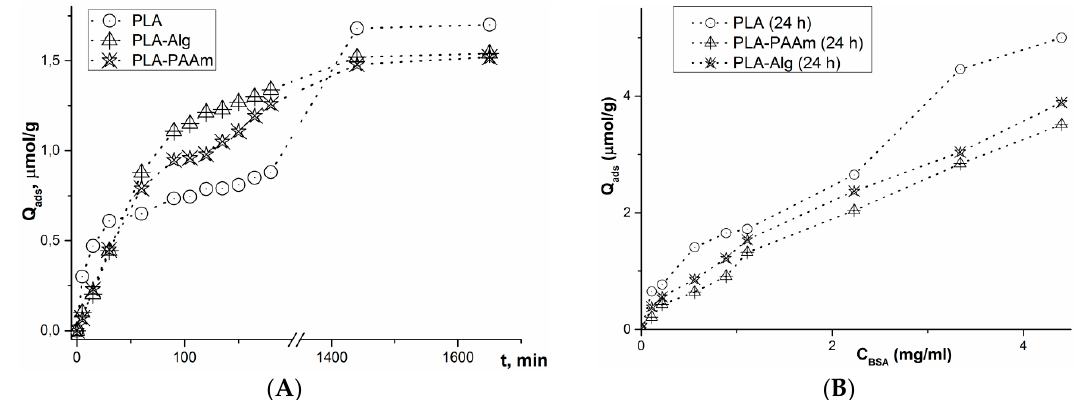
Figure 10. Kinetic curves ( A ) and isotherms ( B ) of BSA adsorption on the surface of the initial and hydrogel modified PLA films.